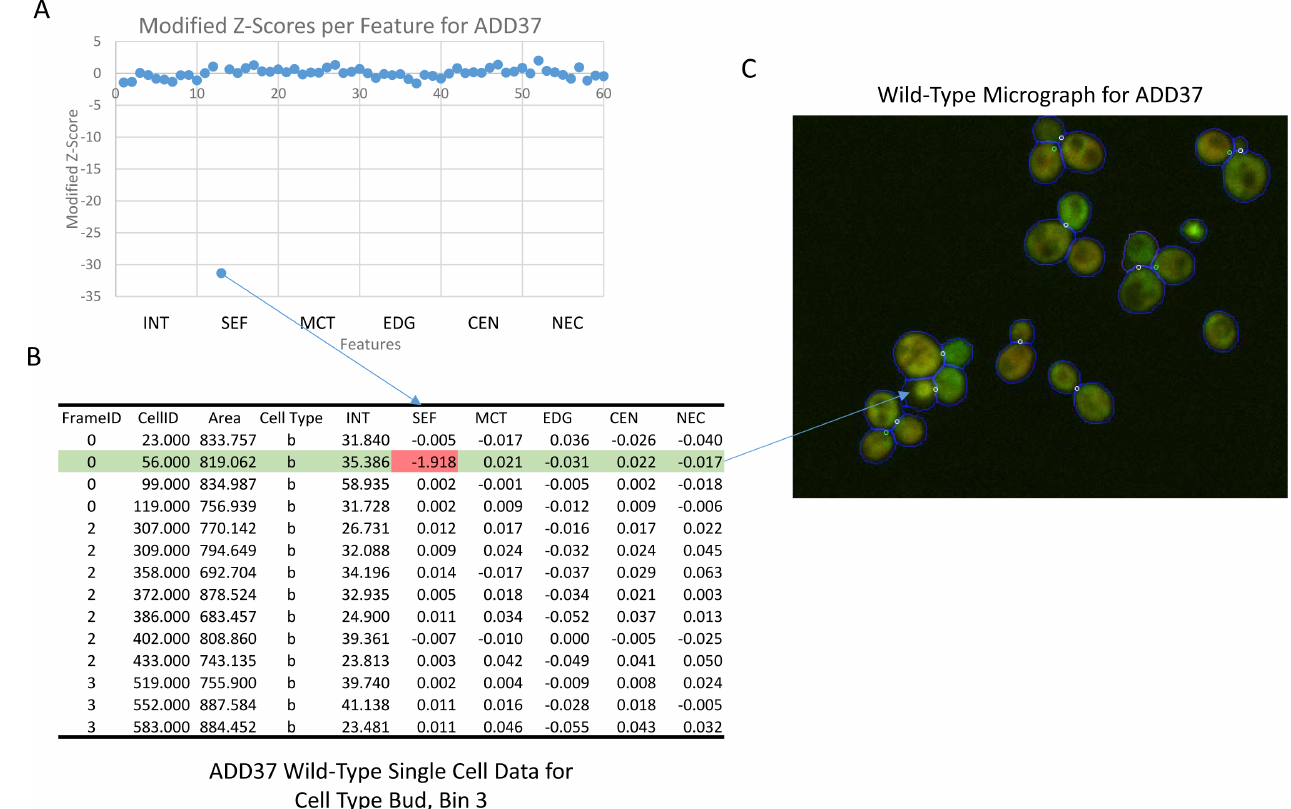
Fig 3. Example of a false positive generated by outliers in single-cell data. ADD37 is reported as a top-ranked gene for localization change using mean profiles despite no obvious phenotype. A shows the feature for distance between proteins is very strongly negative in bud cells in bin 3. The single cell-data for this bin is shown in B, which shows a single cell has a disproportionately high value for this feature, skewing the mean. Looking up this cell in the micrograph in C shows that the cell is either mis-segmented or expressing the protein differently from other cells. Feature abbreviations can be found in the “ Visualization of Results ” section in the